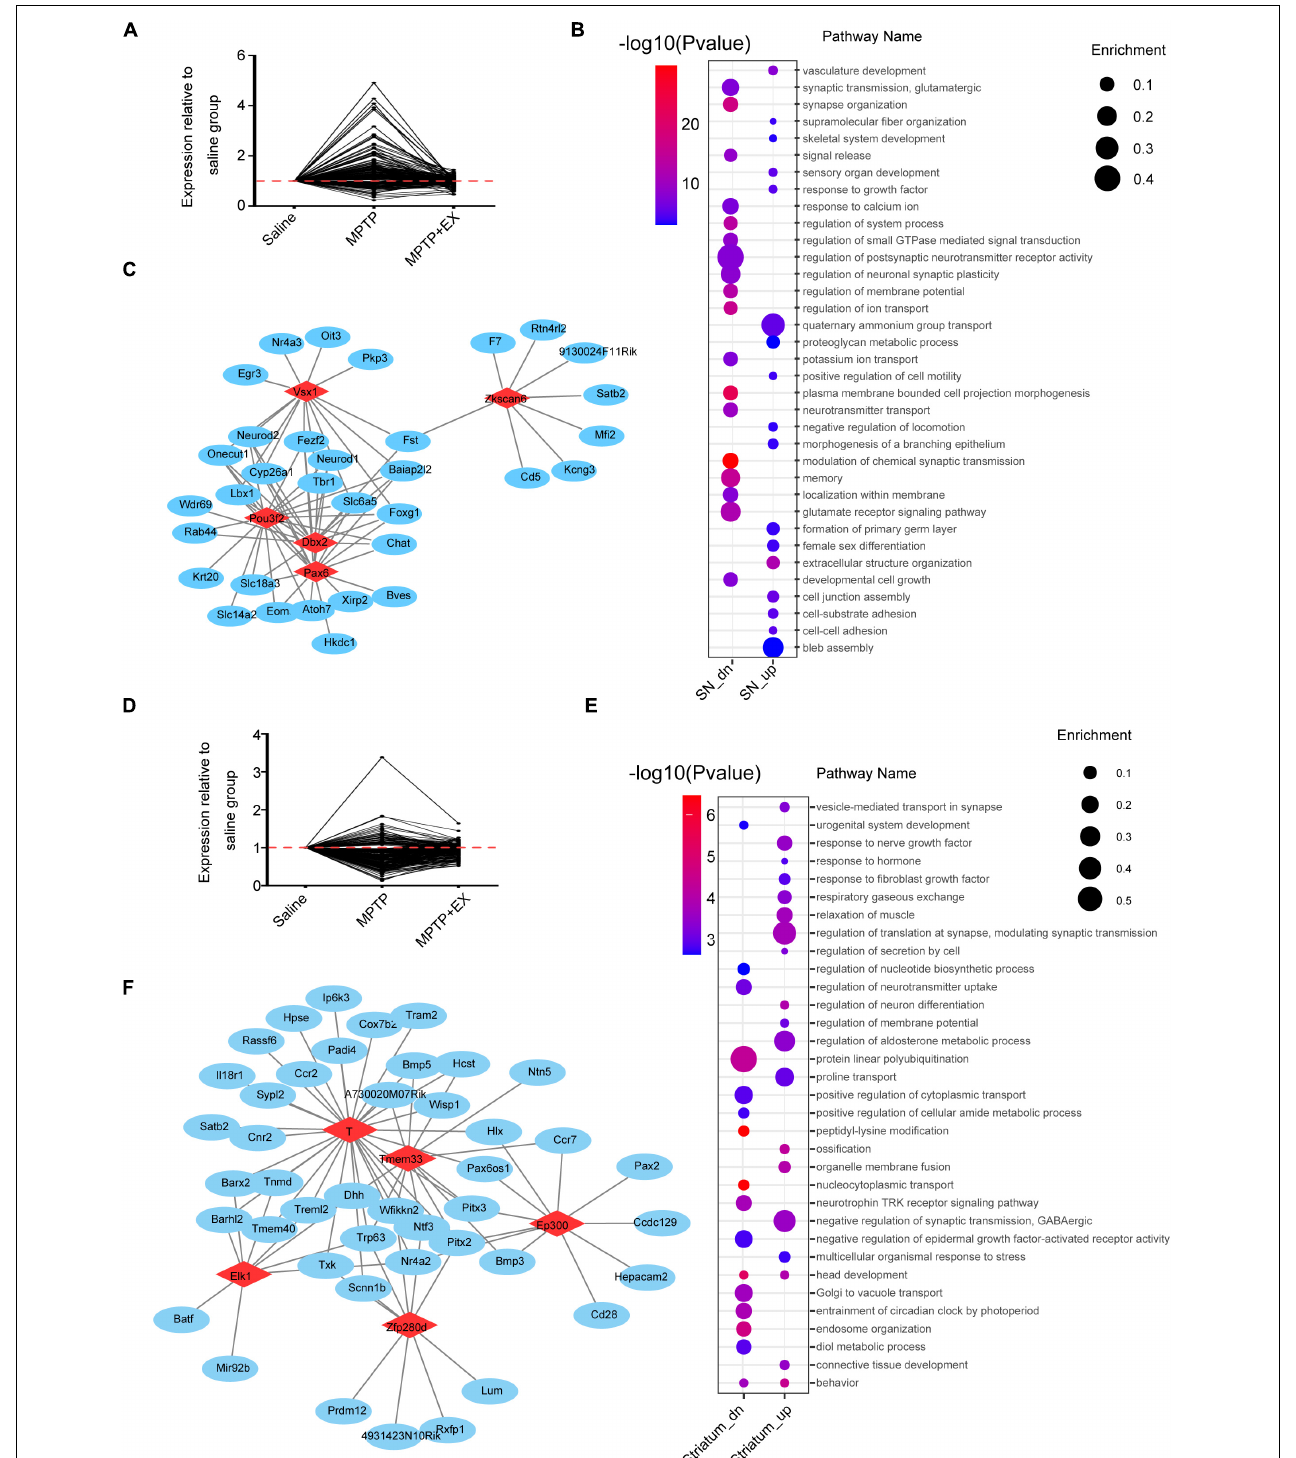
FIGURE 3 | Remarkably different genes among the individual region. (A) Genes upregulated in the MPTP group (MPTP vs. saline) and downregulated in the MPTP + EX group (MPTP + EX vs. MPTP) in SN (FPKM > 1, P < 0.05). (B) Representative pathways enriched in SN (Enrichment: the ratio of observed gene numbers to expected gene numbers). (C) Transcription factor analysis in SN. Red nodes resemble transcriptional factors (TFs) and blue nodes are corresponding promoters, demonstrating a transcriptional regulation between TFs and genes. (D) Genes upregulated in the MPTP group (MPTP vs. saline) and downregulated